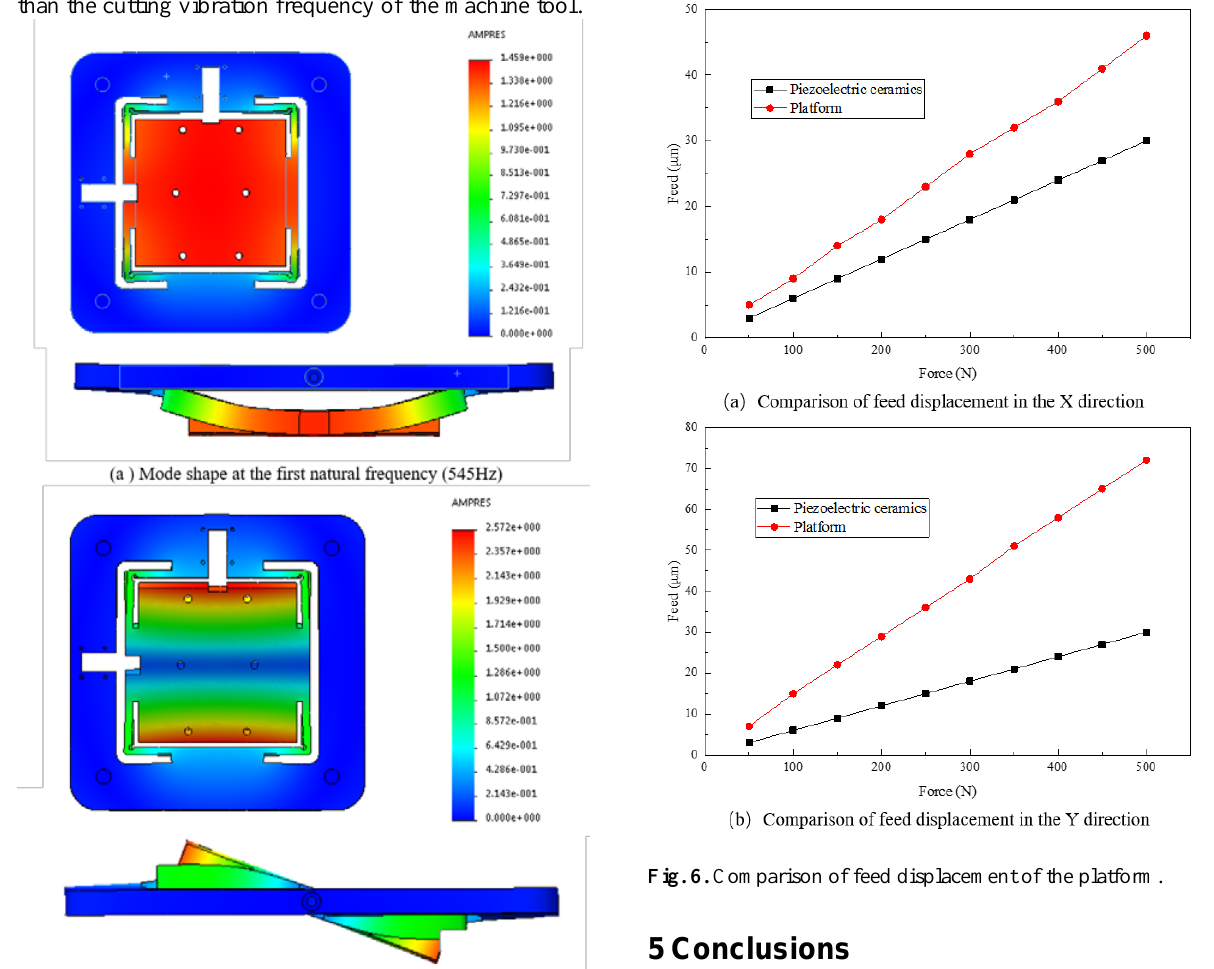
Fig. 4. The displacement and stress of the platform. fifth-order natural frequency is 1059Hz, which is higher than the cutting vibration frequency of the machine tool.